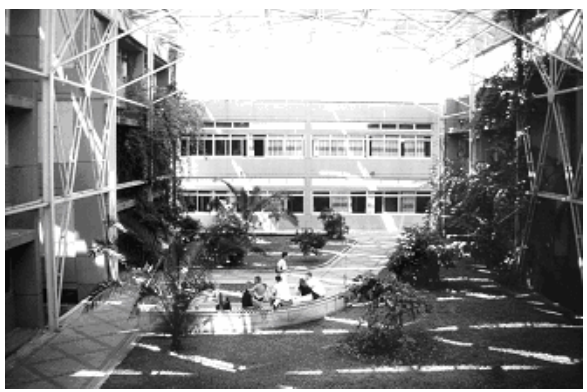
Figure 5. Photograph showing the interior of the Southern Europe atrium.